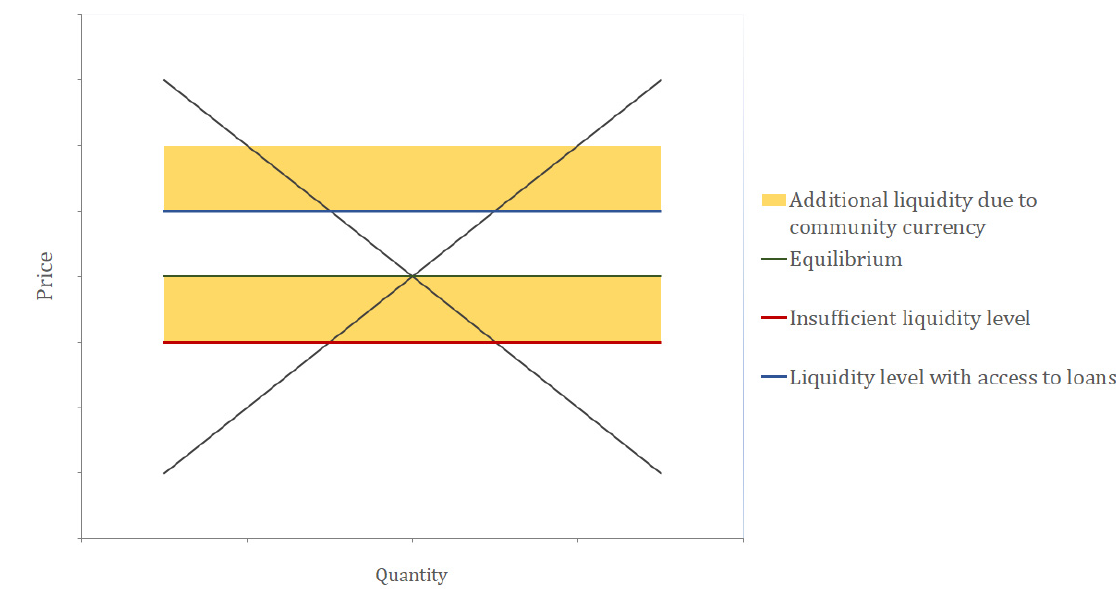
Figure 1. Additional liquidity due to a community currency.